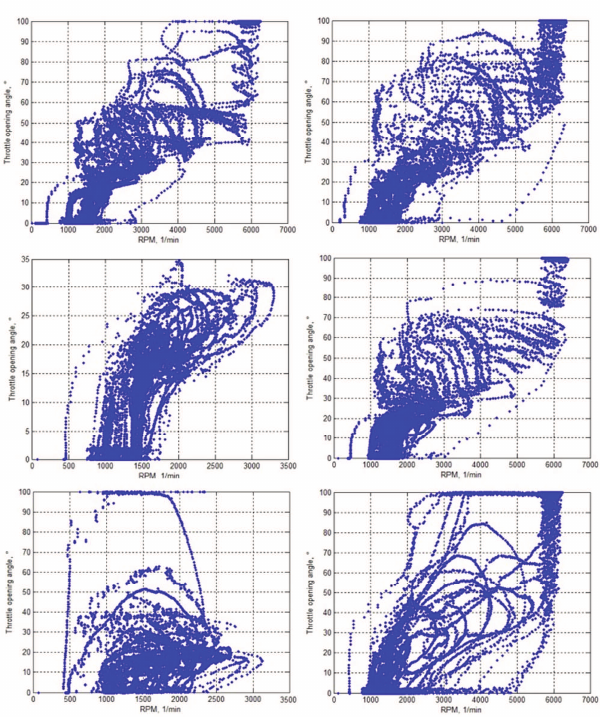
Fig. 1. Engine operation point density during realization of chosen driving cycles The analysis of graphs presented in fig. 1 shows that the greatest density of engine operation points occurs at 10̊, 20 ˚ and 30̊ throttle position and engine speeds of 1500 and Fig. 4. Characteristics of cylinder filling ratio in relation to engine speed 2000 RPM. for chosen throttle repeal angles has a corresponding specific values of cylinder filling ratio, which is shown in Fig. 3.